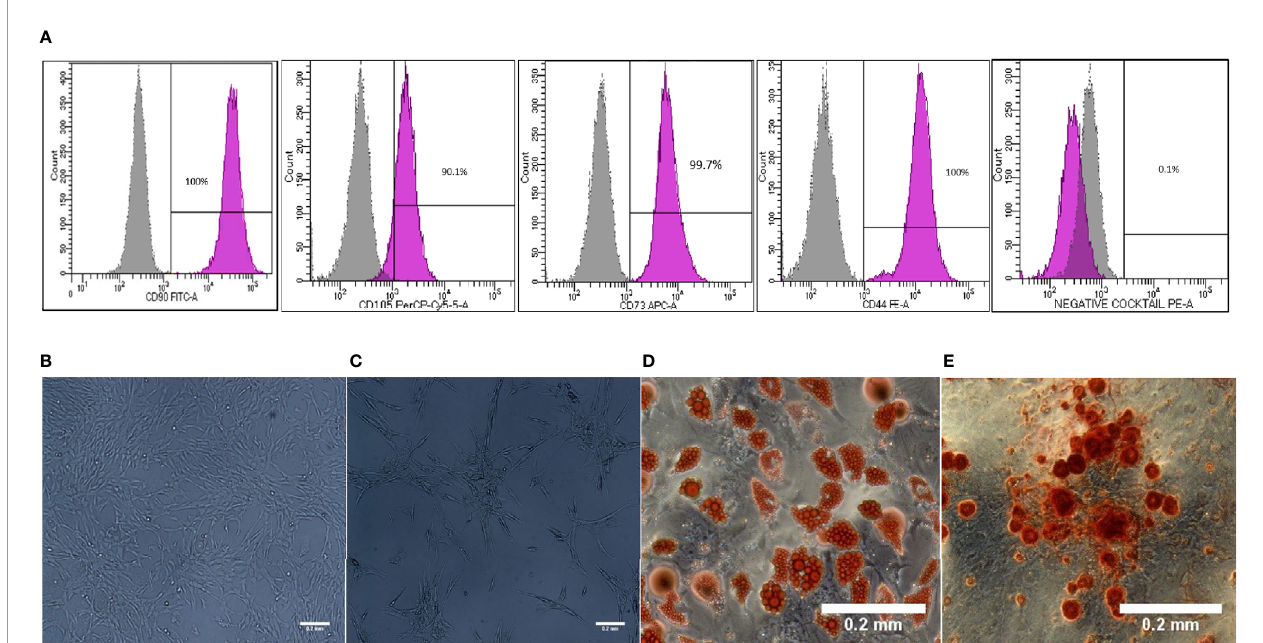
FIGURE 1 | Characterization and differentiation potential of WJ-MSCs priming with IFN- g and TNF- a (A) Representative fl ow cytometry histograms showing high expression of CD90, CD105, CD73 and CD44 and lack the expression of negative MSCs cocktail (CD34, CD11b, CD19, CD45 and HLA-DR). Gray peak corresponds with isotype control and the violet peak corresponds with the antibodies. (B) Unprimed WJ-MSCs. (C) Primed WJ-MSCs. (D) Oil red staining of primed WJ-MSCs after culture in adipogenic differentiation media. (E) Alizarin red staining of primed WJ-MSCs after culture with Osteogenic differentiation media. Data were calculated from fi ve samples. Experiments performed in triplicate for each sample. Data were analyzed using FACS canto II. Magni fi cation = 100x.